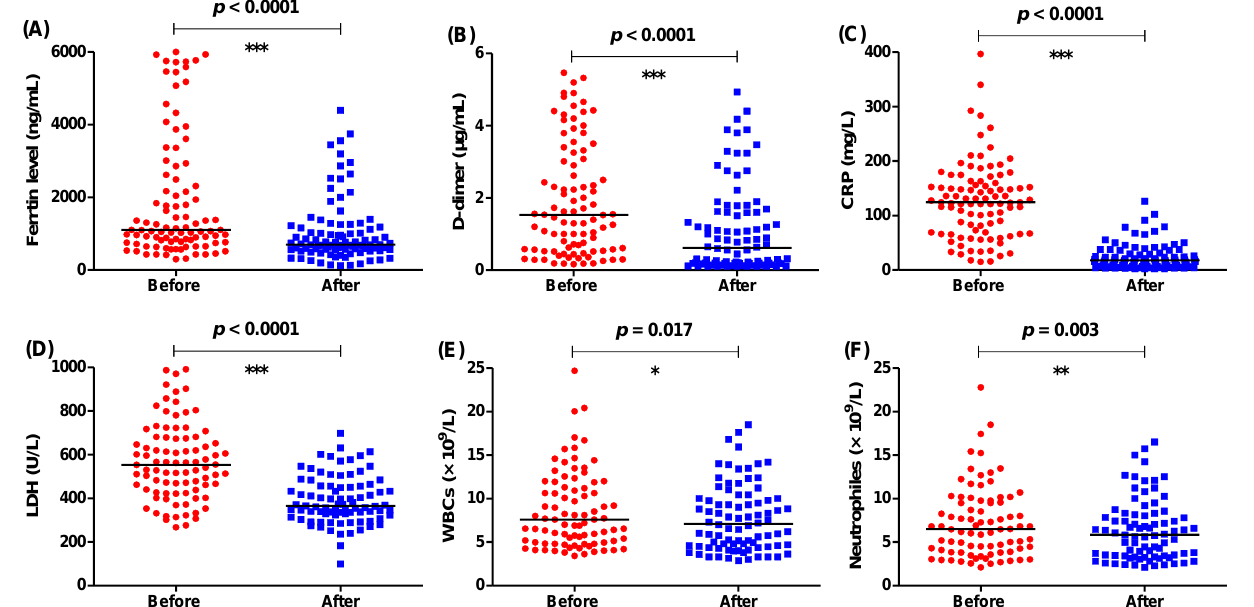
Figure 2. The levels of different parameters before and after administration of treatment regimen with interleukin-1 antagonist anakinra. The levels of ( A ) ferritin, ( B ) D-dimer, ( C ) CRP, ( D ) LDH, ( E ) WBCs, and ( F ) neutrophiles were measured before and after completion of treatment regimen. *** = p ≤ 0.001, ** = p < 0.01, * = p ≤ 0.05, and ns (nonsignificant) p > 0.05.